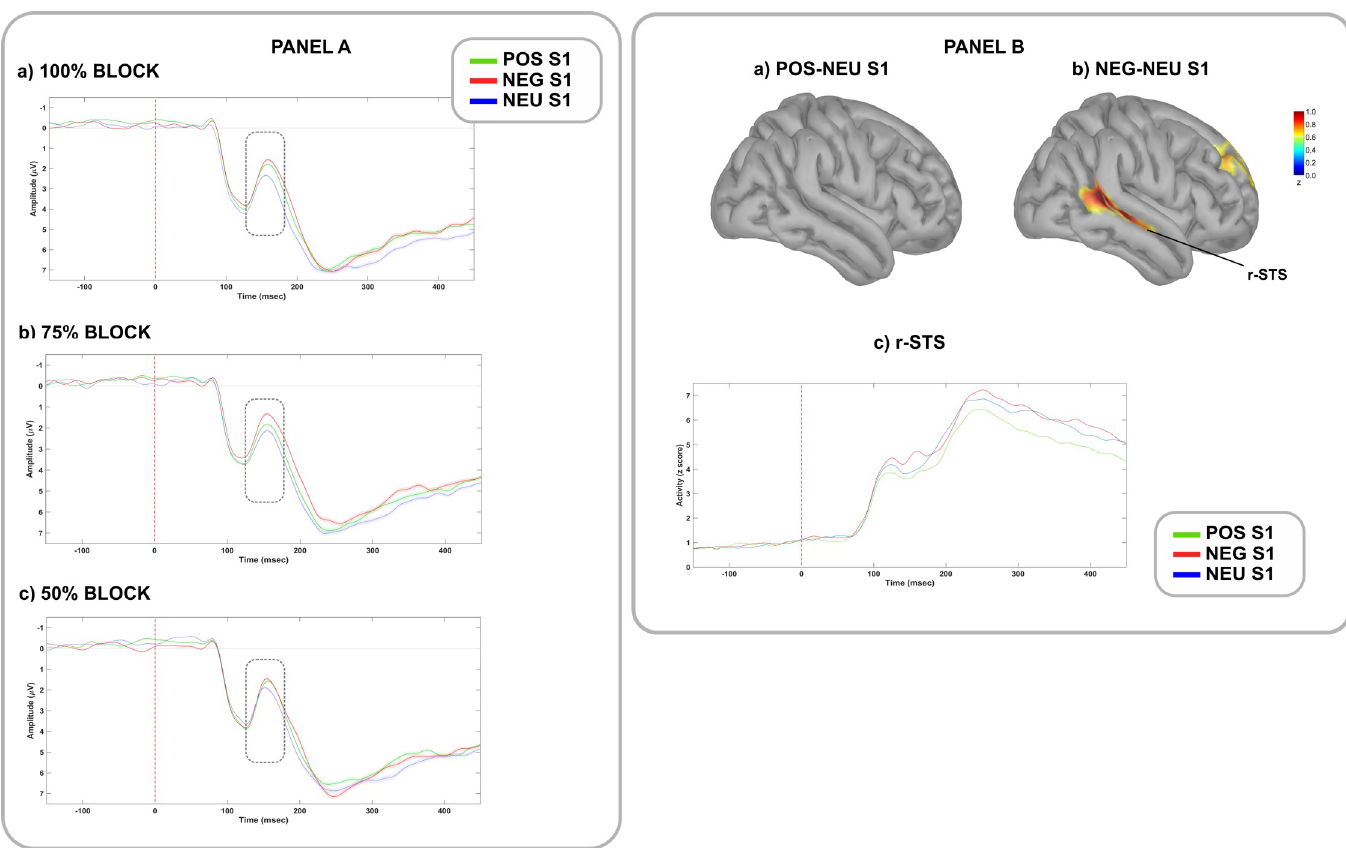
Fig 1. Modulation of ERPs and brain sources during prediction generation stage. PANEL A: Grand average ERP waveforms following negative (red lines), positive (green lines) and neutral (blue lines) faces (S1) in the (a) 100% , (b) 75% and (c) 50% blocks. Waveforms are plotted from an occipital cluster of electrodes (E70, E74, E75, E81, E82, E83). Shaded areas denote standard error. The N170 was computed between 140 and 180 msec from S1 onset (time 0). PANEL B: On the top, cortical maps reconstruction of the (a) POS-NEU and (b) NEG-NEU differences in brain activations in the N170 temporal window (140–180 ms), regardless of blocks. On the bottom, time course of (c) r-STS activations to positive (green lines), negative (red lines), and neutral (blue lines) faces, regardless of blocks. r-STS = right superior temporal